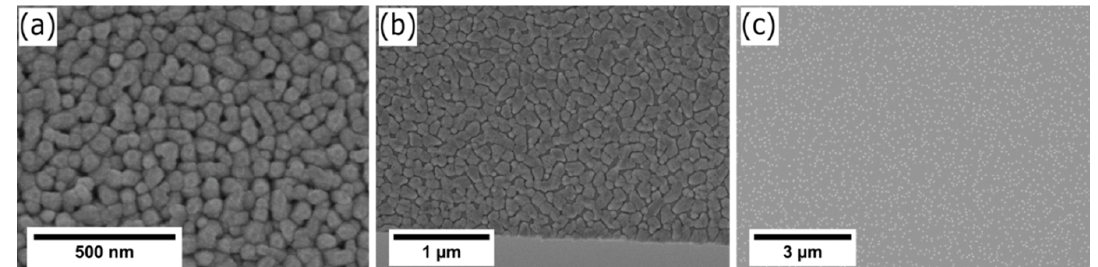
Figure 2. Top-view SEM images of the ZnO nanostructures morphology according to the substrate position during the growth process: ( a ) in the front, ( b ) in the center and ( c ) in the back of the ceramic boat. The structures have been grown within the same process at 550 °C, 50 sccm Ar and 25 sccm O 2 flow.